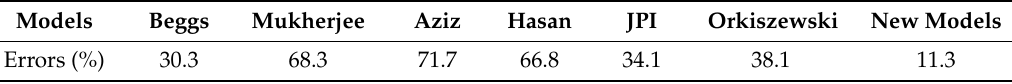
Table 4. Comparison of prediction errors of